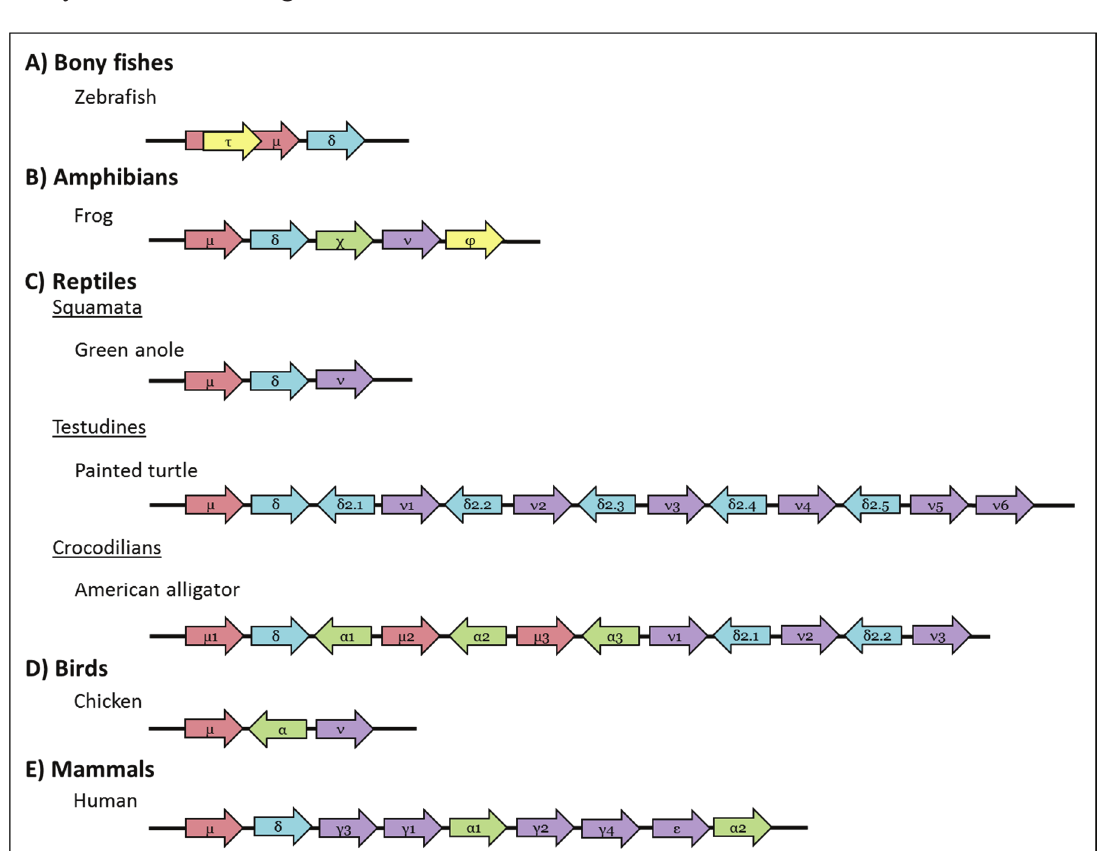
Figure 3. Schematic representation of genomic organisation of the IgH locus in ( A )